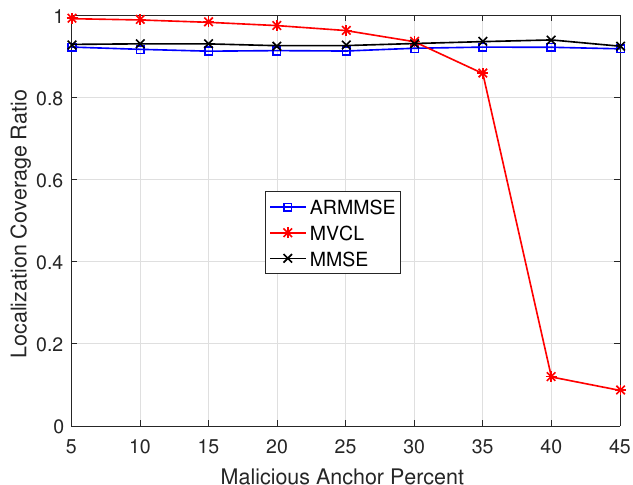
Figure 15. Localization coverage ratio with malicious anchor percent p ( n = 80, m = 20, R = 30, ζ = 15, η = 3).